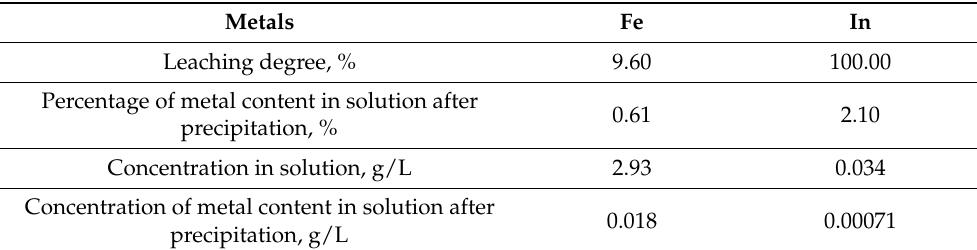
Table 5. Percentages of metals in the solution after leaching and precipitation. Metals Fe In Leaching degree, % 9.60 100.00 Percentage of metal content in solution after 0.61 2.10 precipitation, % Concentration in solution, g/L 2.93 0.034 Concentration of metal content in solution after precipitation, g/L